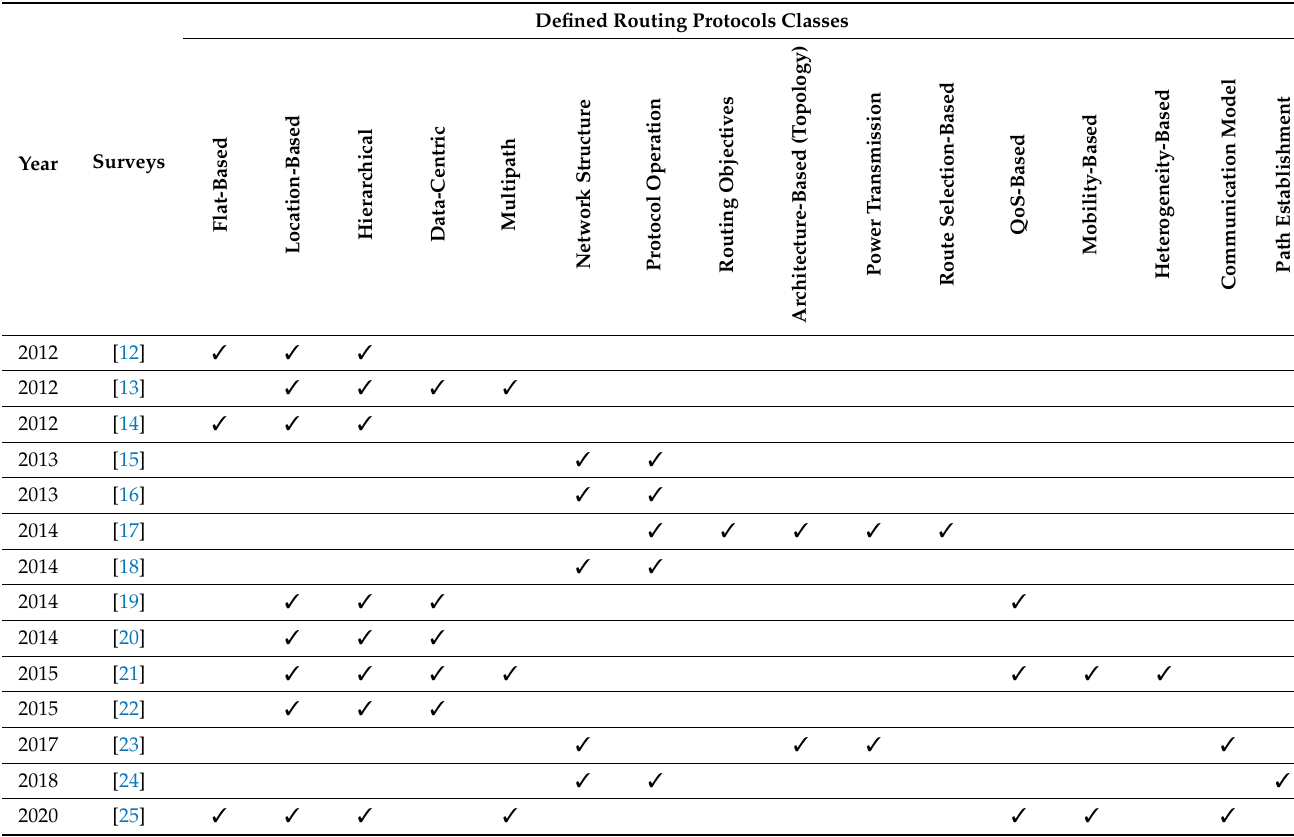
Table 1. Surveys of wireless sensor networks (WSNs) routing